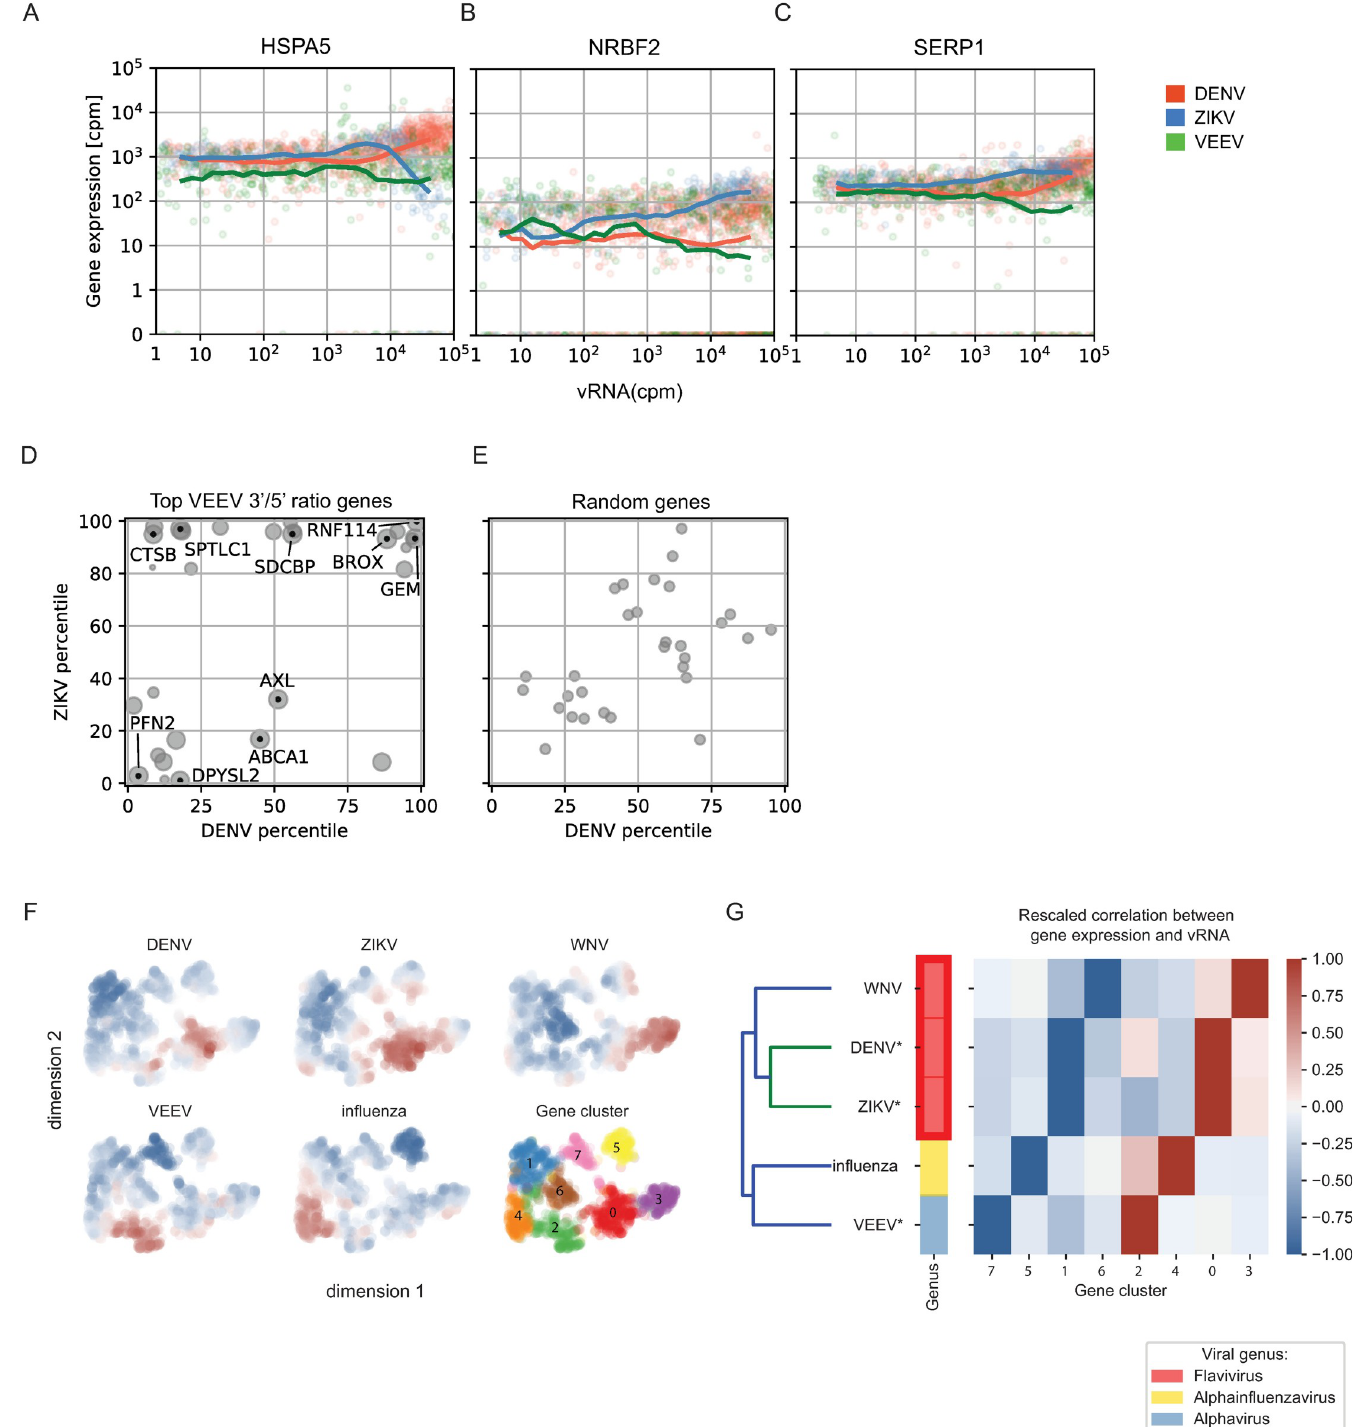
Fig 6. Comparative viscRNA-Seq analysis across five RNA viruses. (A-C) Scatter plots of representative host gene expression versus vRNA in single cells during DENV (orange), ZIKV (blue), and VEEV-TC-83 (green) infection. Dots indicate single cells, lines are running averages at increasing vRNA abundances. (D, E) Correlation between host gene expression and vRNA abundance during DENV versus ZIKV infection of the top genes that positively correlate with the VEEV 3’/5’ read ratio (D) or a similar number of random genes (E). Each dot is a gene and the axis coordinate is the percentage of genes with a correlation with vRNA smaller than the the gene of interest. For (D), size of the dot increases with the correlation with VEEV 3’/5’ read ratio (top correlated gene is the largest). (F) UMAP [56] embedding of